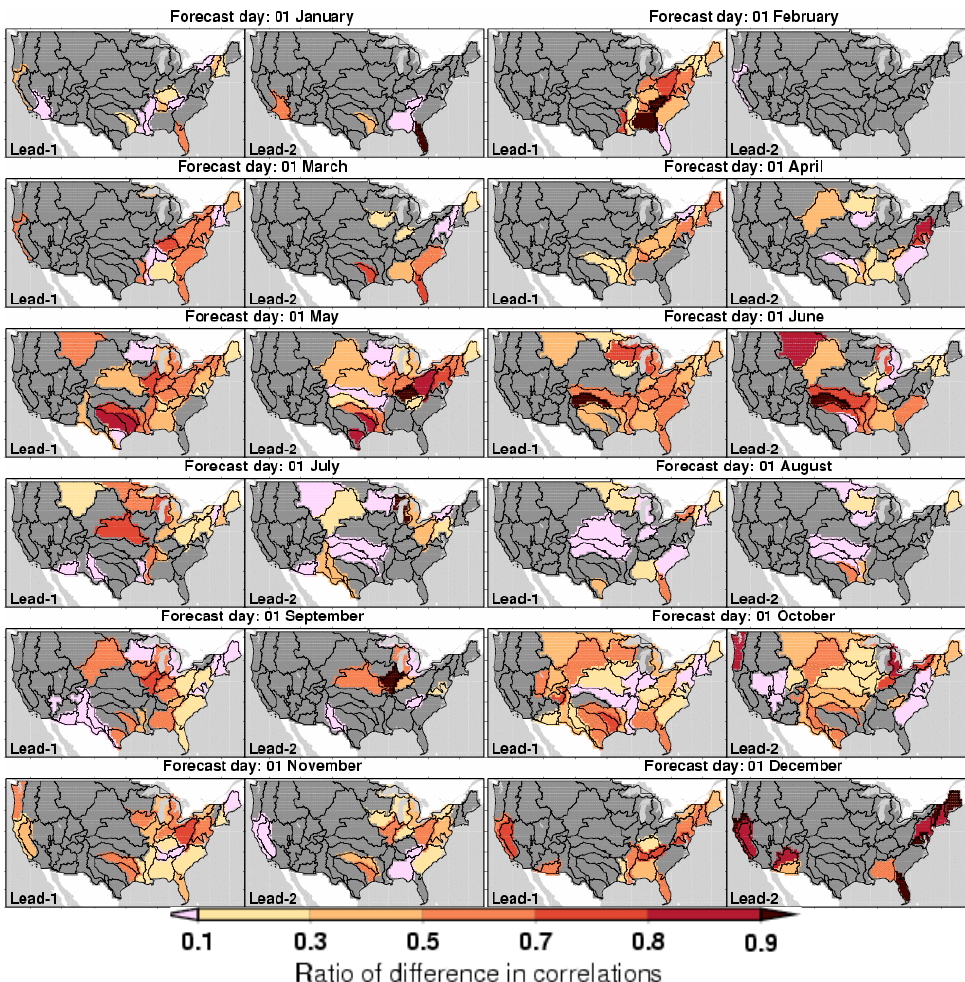
Figure 9: The ratio of actual improvement and potential improvement in baseline SM 3 Fig. 9. The ratio of actual improvement and potential improvement in baseline SM forecast skill at leads 1–2 months (dark grey color shows the sub-regions where either the potential improvement in skill is < 0.1 or the skill of OBS Merged ESP is not significant at the 95% forecast skill at leads 1-2 months. (Dark grey color shows the sub-regions where either 4 significance the potential improvement in skill is < 0.1 or the skill of OBS_Merged_ESP is not 5 significant at 95% significance level.) 6